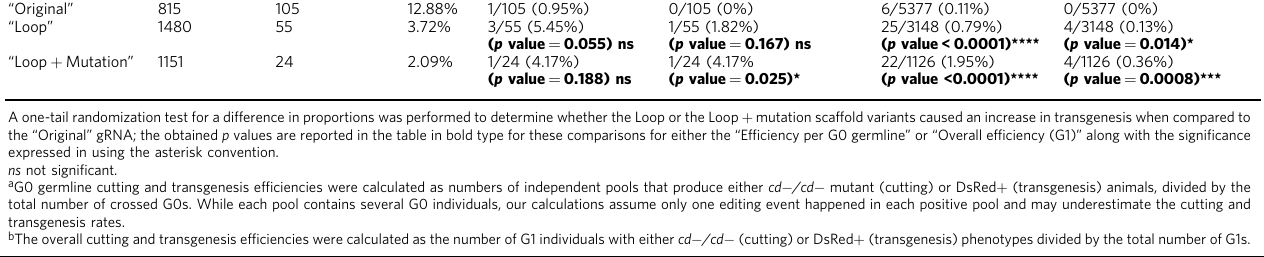
Table 1 Culex quinquefasciatus cutting and transgenesis ef fi ciencies of different HDR templates. HR plasmid